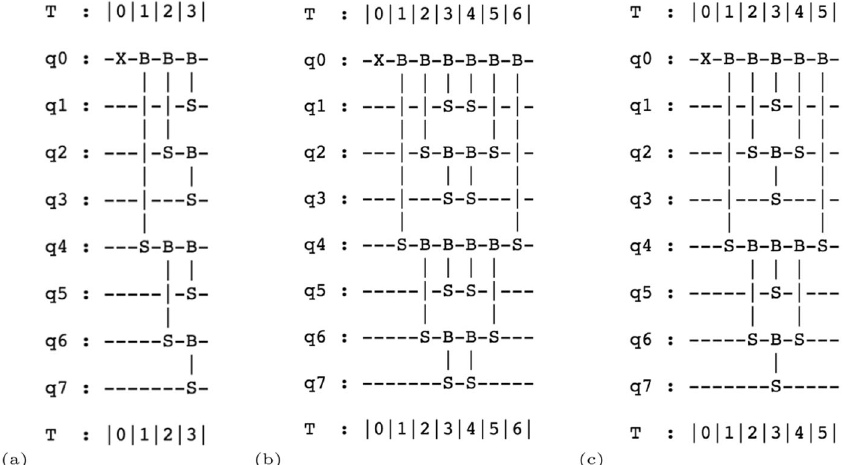
Fig. 1 Circuit constructions. a The data loader circuit for an 8-dimensional data point. The angles of the RBS ( θ ) gates starting from left to right and top to bottom correspond to ( θ 1 , θ 2 , … , θ 7 ). b The distance estimation circuit for two 8-dimensional data points. The circuit in time steps 0 – 3 corresponds to the parallel loader for the fi rst data point and the circuit in time steps 4 – 6 corresponds to the inverse parallel loader circuit for the second data point (excluding the last X gate). The probability the fi rst qubit is measured in state 1 j i is exactly the square of the inner product of the two data points. c The optimized distance estimation circuit for two 8-dimensional data points. Each pair of RBS gates that are applied to the same consecutive qubits in time steps 3 and 4 in the circuit of b are combined to one gate whose parameter θ is equal to θ 1 + θ fi rst gate and θ θ 2 , where 1 is the parameter of the 2 is the parameter of the second